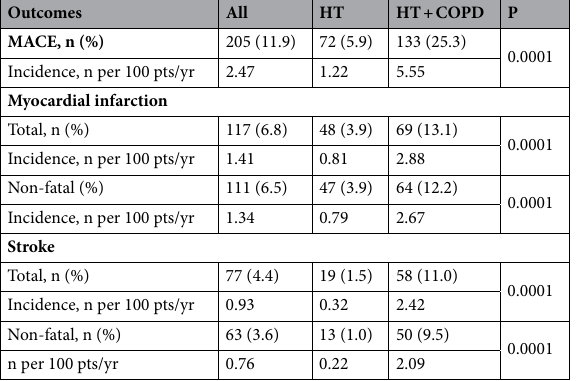
Table 3. Incidence of study outcomes during the follow-up period in the whole study population and in the two groups separately. MACE: major adverse cardiovascular